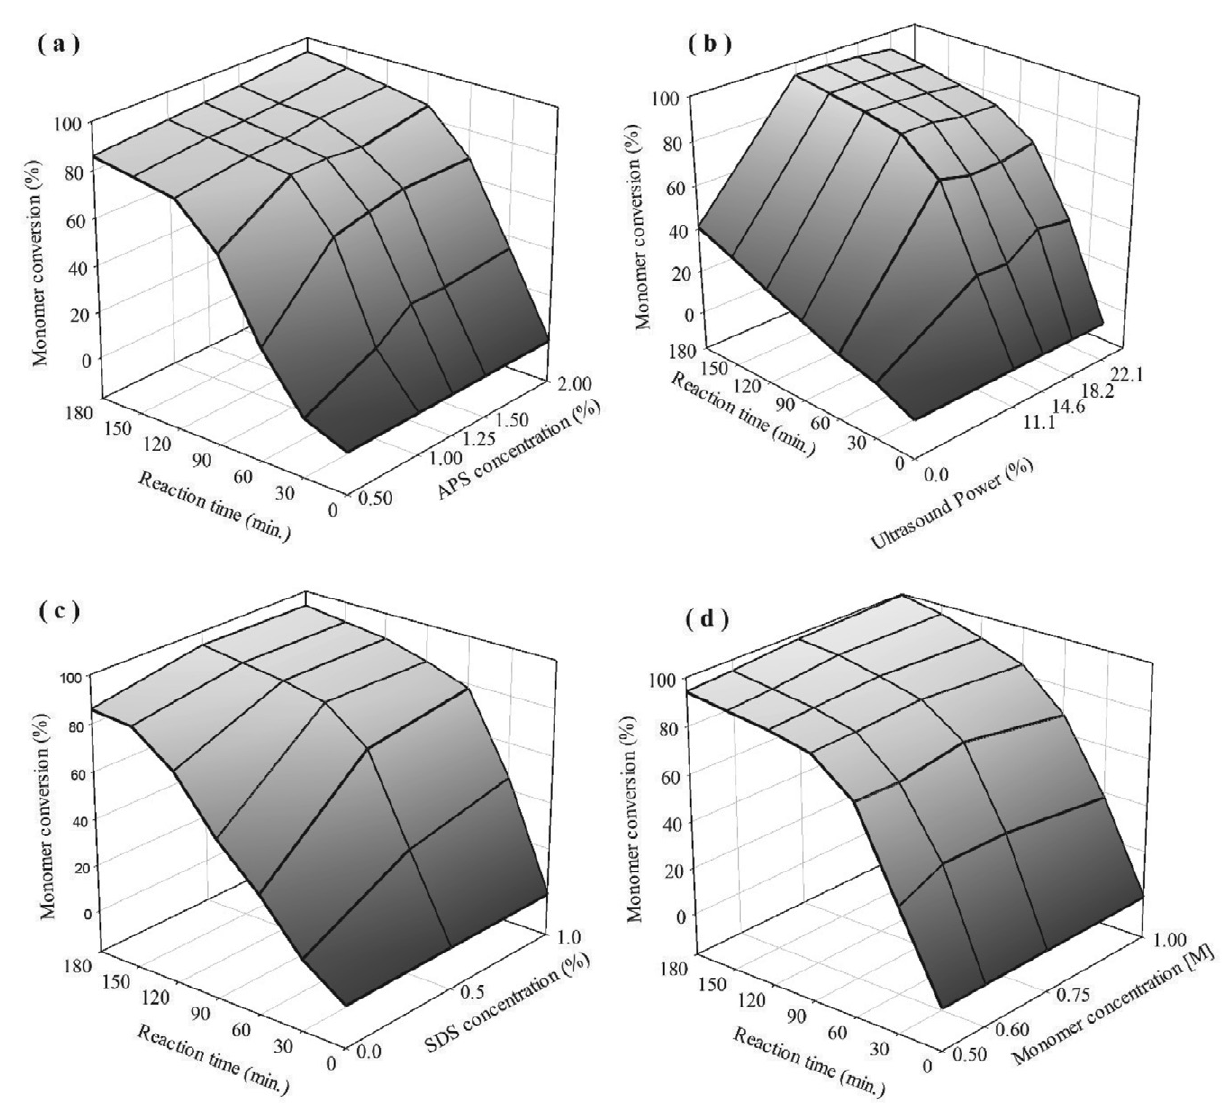
Fig. 2. (a) Effects of initiator concentration, (b) ultrasound calorimetric power, (c) SDS amount and (d) initial monomer concentration on the mon- omer